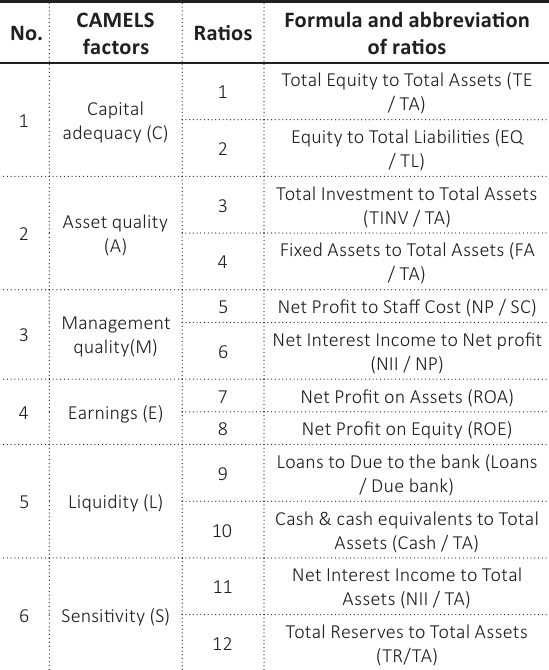
Table 2. CAMELS factors and measurement